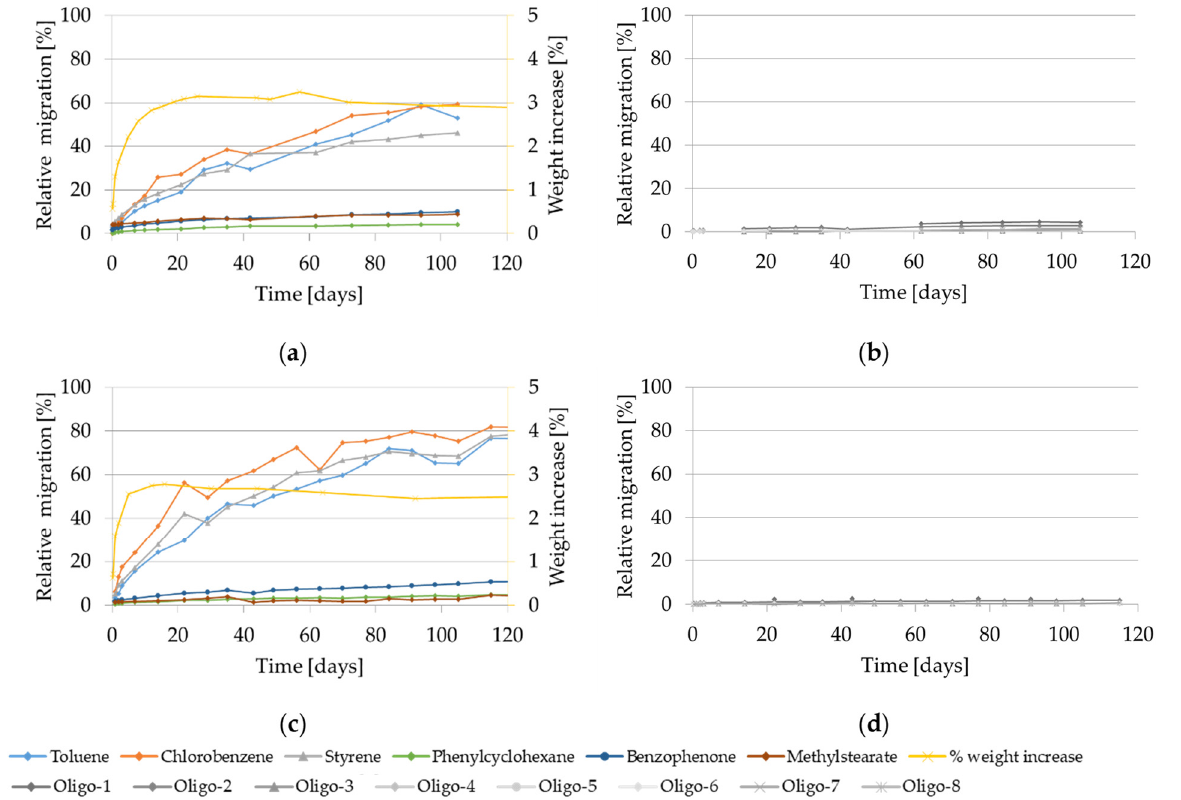
Figure 5. Migration kinetics and weight increase in 95% ethanol at 40 °C: ( a ) Model substances and styrene from GPPS; ( b ) Styrene oligomers from GPPS. ( c ) Model substances and styrene from HIPS; ( d ) Styrene oligomers from HIPS.